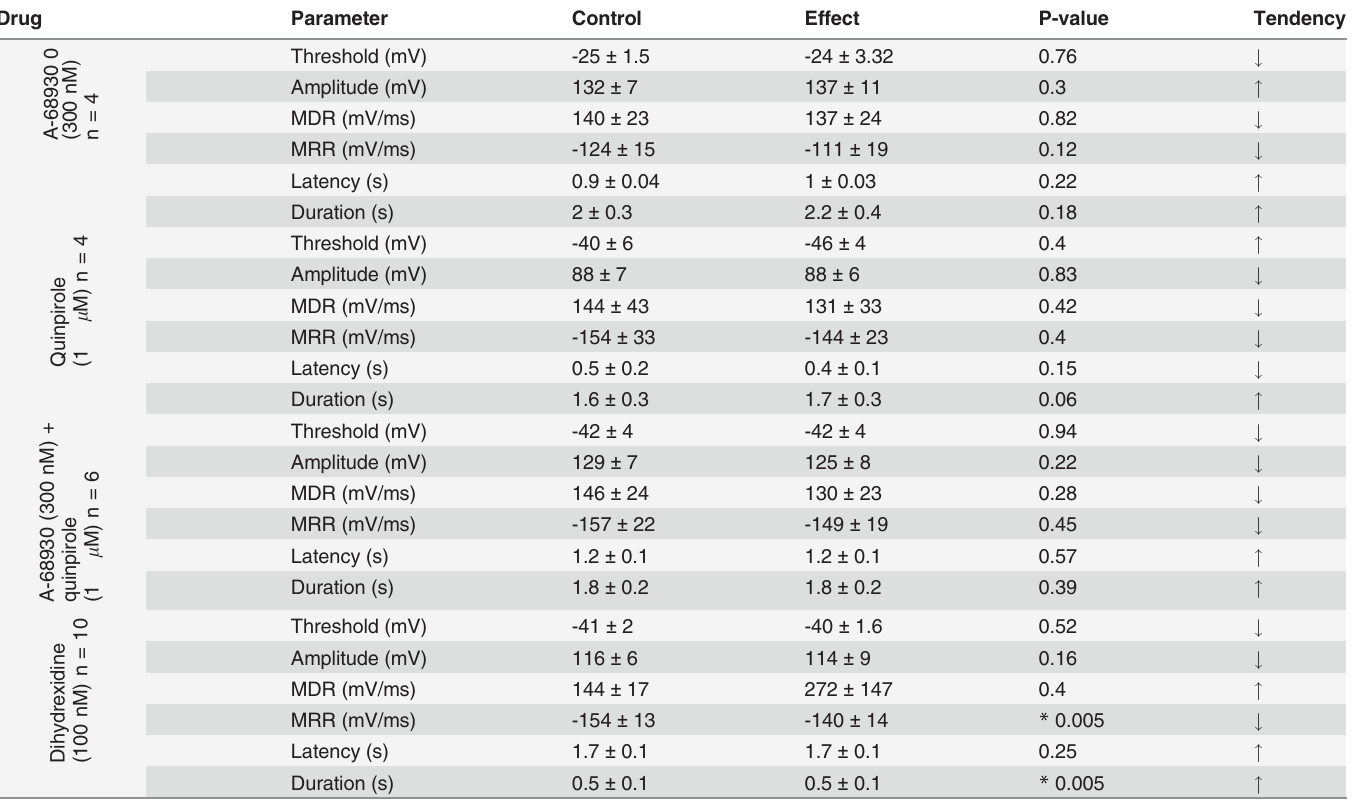
Table 1. Action potential parameters in control conditions and after drug use.